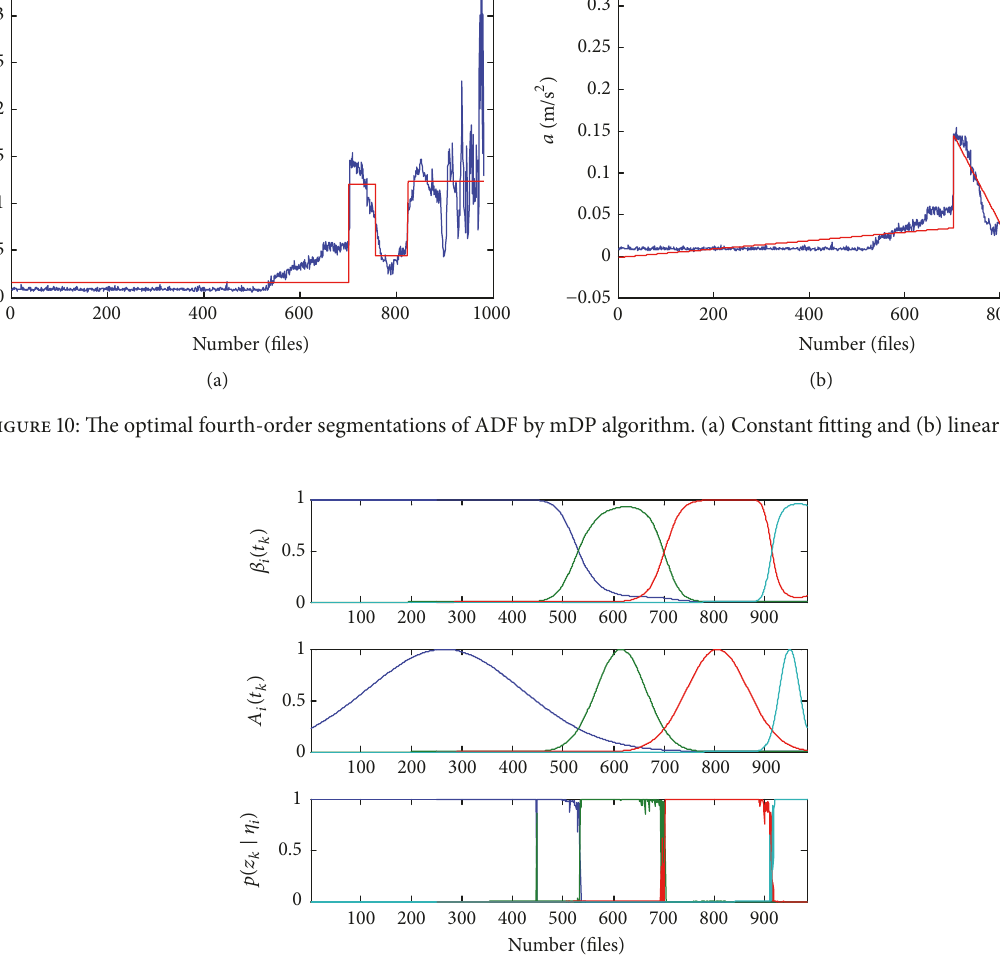
Figure 11: The result of the ADF based on